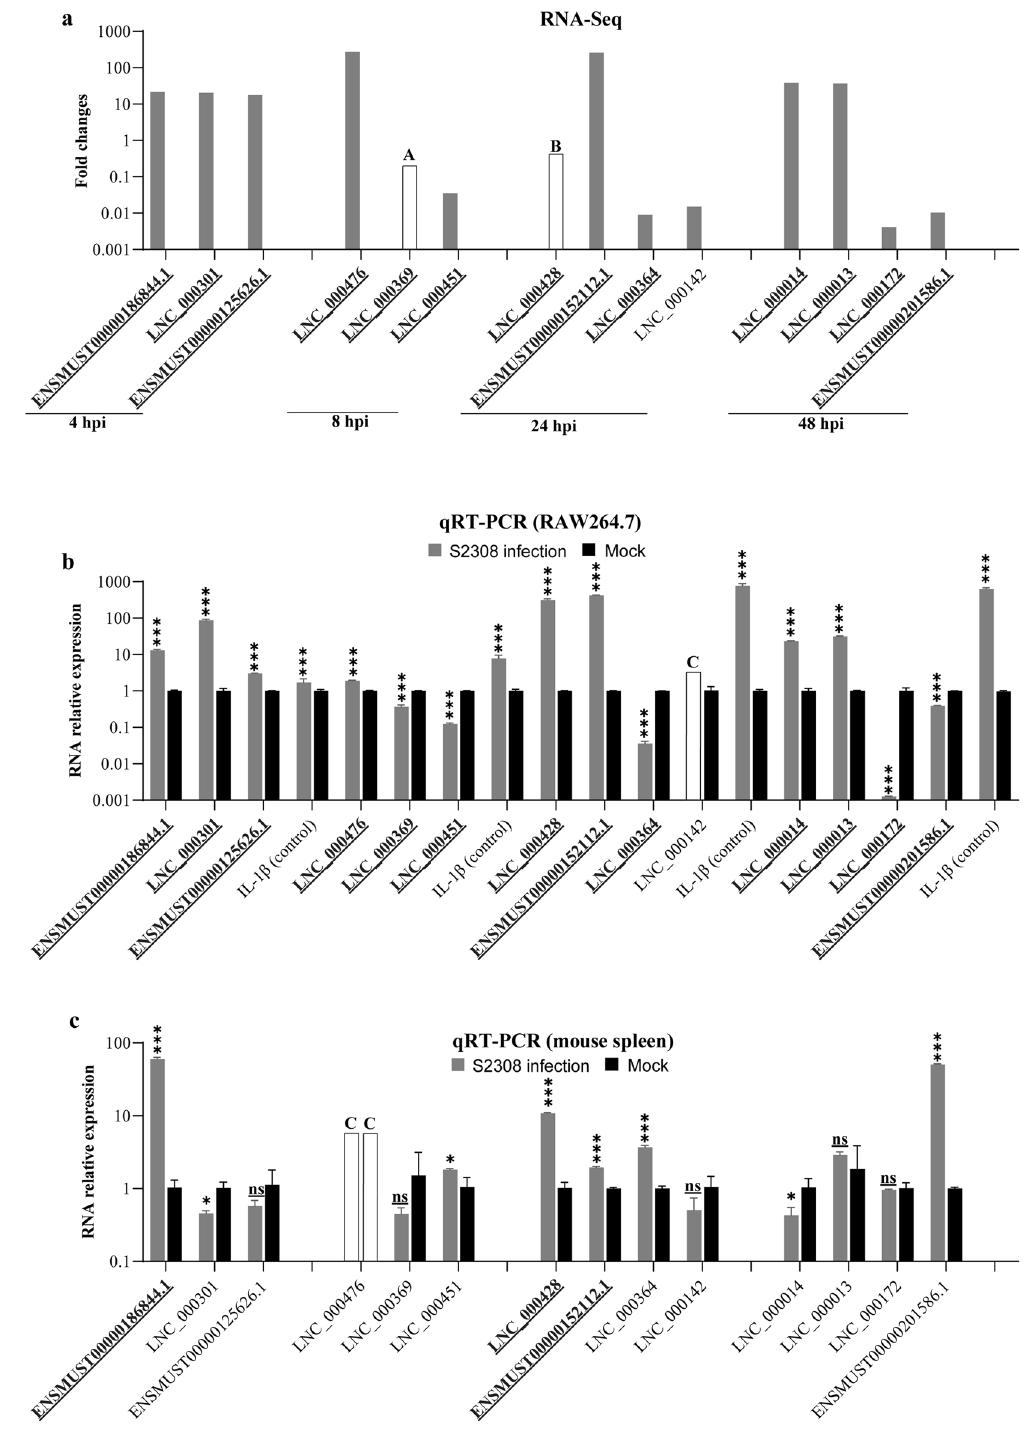
Figure 4. qRT-PCR validation of differentially expressed lncRNAs in S2308-infected RAW264.7 cells and mice. ( a ) 14 differentially expressed lncRNAs with greater than 16-fold changes found by transcriptomic analysis in RAW264.7 cells with infection of Brucella abortus S2308 for 4, 8, 24 and 48 h were selected for further verification. ( b ) The selected 14 lncRNAs were verified by qRT-PCR on RAW264.7 macrophages infected with S2308 at 1000 MOI for 4, 8, 24 and 48 h. Relative RNA expression was decided by normalizing the expression of lncRNA to Gapdh . Expression of IL-1β was used as the control for detection. ( c ) Expression of the 14 selected lncRNAs in the spleens of mice infected with S2308 were verified at 24 h post infection by qRT-PCR. Relative RNA expression was decided by normalizing the expression of lncRNA to Gapdh . Bold underlined gene names represent the differentially expressed lncRNAs, which were confirmed by RT-PCR. hpi: hours post-infection. A: Expression fold change in RNA-Seq data is infinitely great while the expression quantity in an infected group is approximately zero; B: The value in RNA-Seq data is infinitely great while the expression quantity in a mock group is approximate to zero; C: lncRNA was not applicable for detection by qRT-PCR. * P < 0.05; *** P < 0.001; ns, not